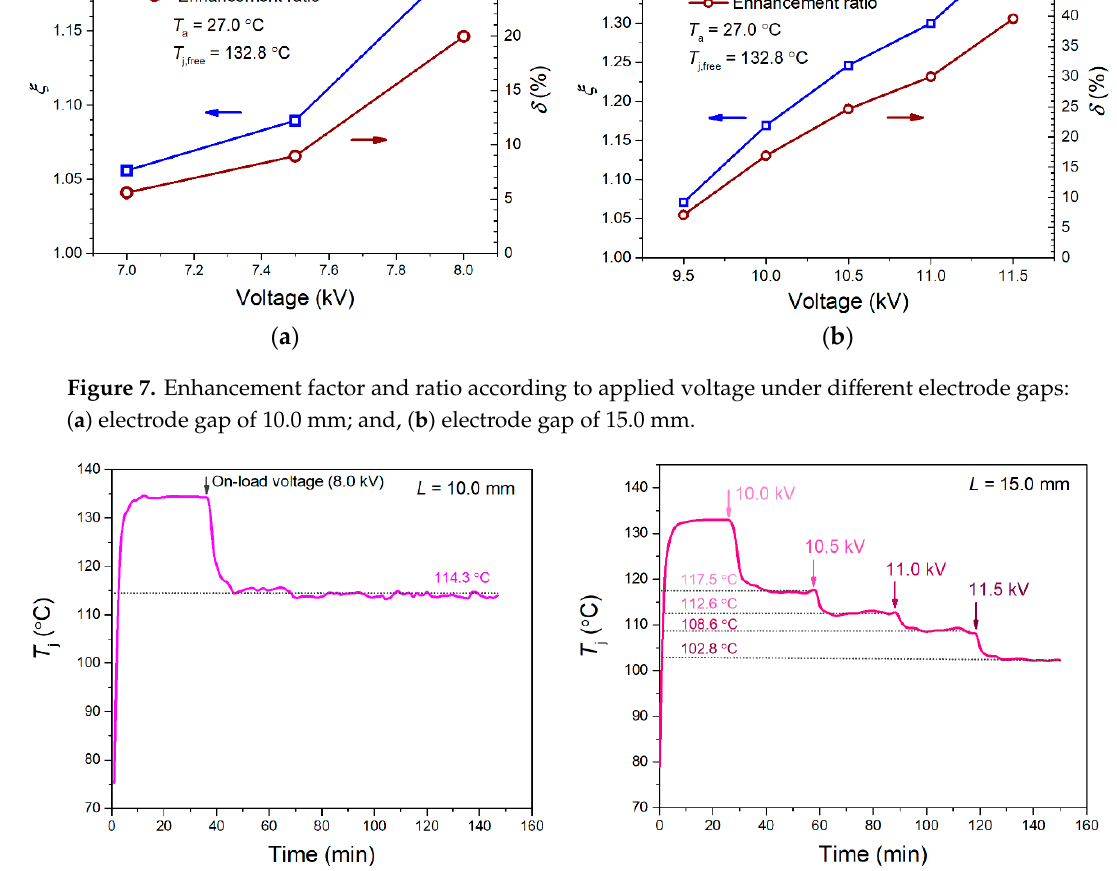
Figure 7. Enhancement factor and ratio according to applied voltage under different electrode gaps: ( a ) electrode gap of 10.0 mm; and, ( b ) electrode gap of 15.0 mm.